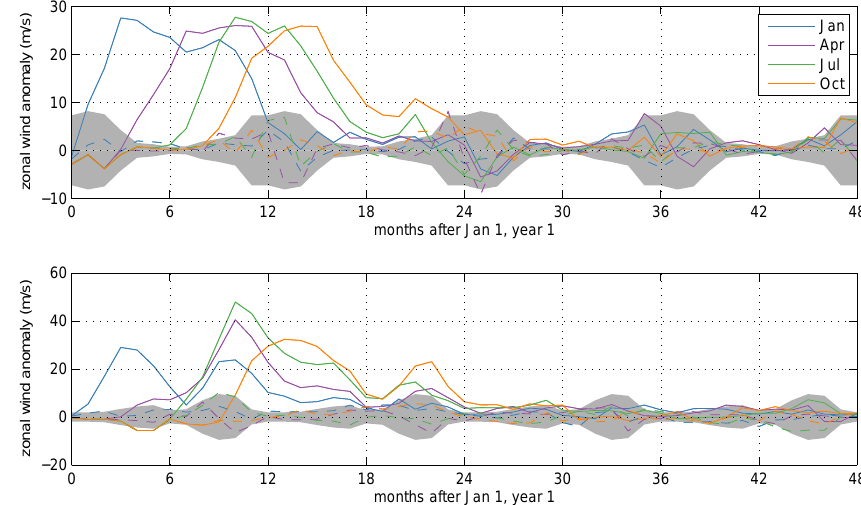
Fig. 9. Zonal mean zonal wind anomalies at 50hPa and 60 ◦ N (top) and 60 ◦ S (bottom) for E700 (solid lines) and E17 (dashed lines) eruption simulations. Anomalies outside the gray shading are significant at the 95% confidence level based on the variability of a control run. Note different scales for the NH and SH plots.